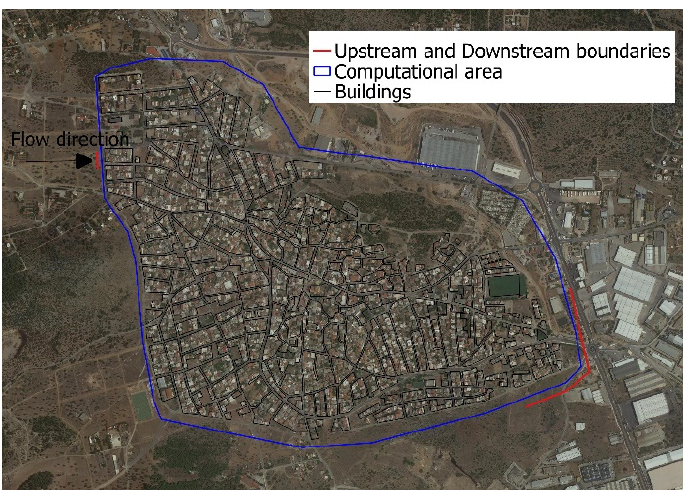
Figure 8. Computational area, upstream/downstream boundaries and buildings footprint used for HEC-RAS and MIKE FLOOD software.